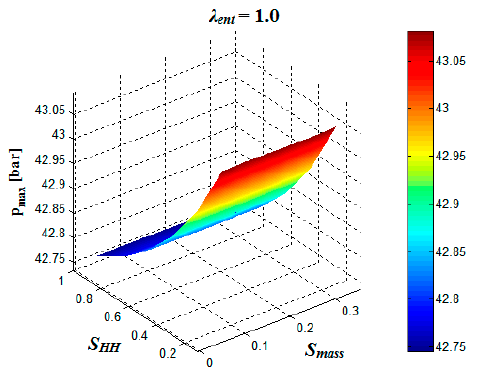
Figure 16. Peak temperature values when S mass is fixed.